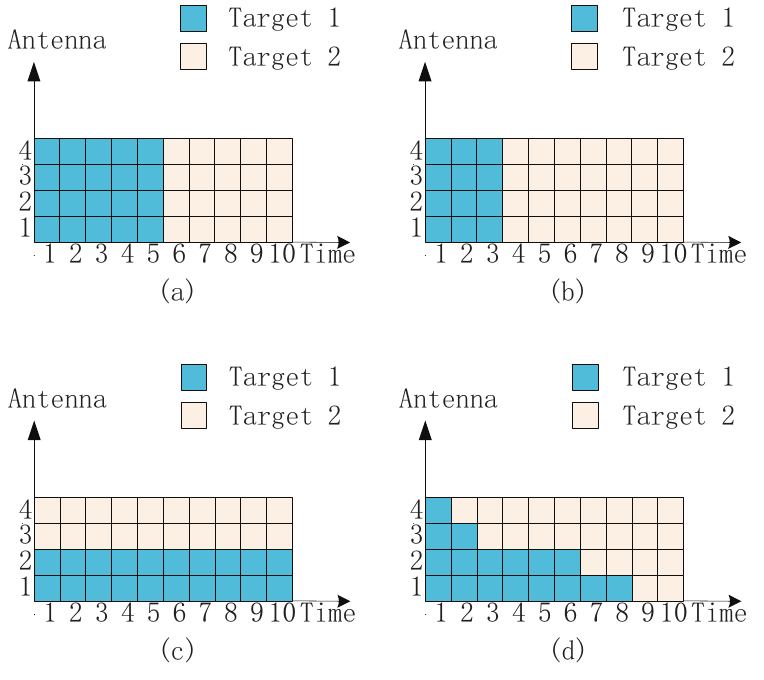
Figure 1. An intuitive explanation of four different illumination schemes: ( a ) uniform allocation; ( b ) time allocation; ( c ) antenna-only allocation and ( d ) antenna-time allocation. The number of antennas is M = 4 , and the total number of signal pulses is L = 10